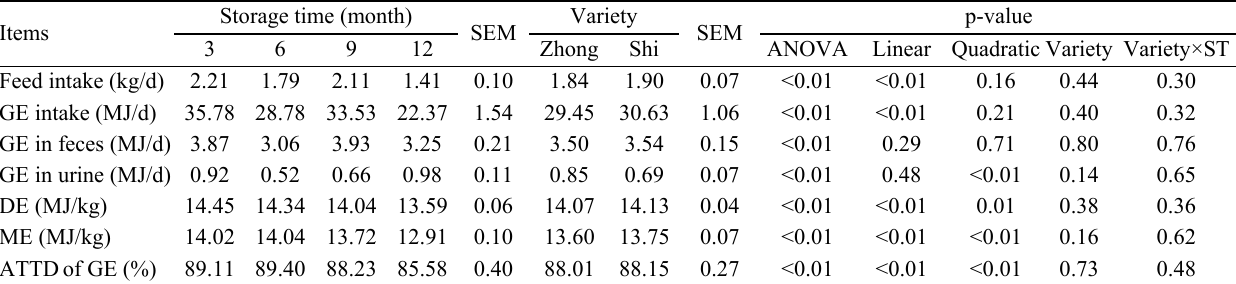
Table 4. Concentration of DE and ME, and ATTD of energy in diets (as-fed basis)